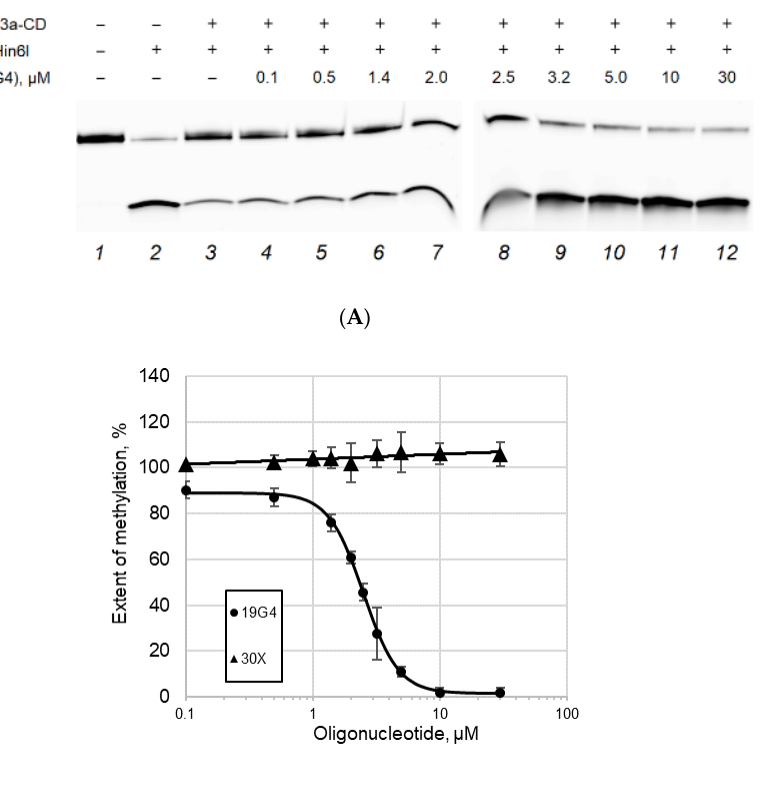
Figure 8. Inhibition of the Dnmt3a-CD-mediated methylation of DNA duplex 30Tf/30Bf (300 nM) by G4-containing oligonucleotide 19G4. Control: a 30-nt oligonucleotide lacking G4 (30X). ( A ) En- donuclease Hin6I-induced cleavage of 30Tf/30Bf after its methylation with 2 µM Dnmt3a-CD in buffer A in the presence of 25 µM AdoMet and 19G4 (concentrations are indicated above the gel lanes). The reaction mixture was analyzed by electrophoresis in 20% polyacrylamide gel containing 7 M urea. ( B ) Extent of methylation as a function of 19G4 or 30X concentration. The standard devi- ations of three independent measurements are presented.